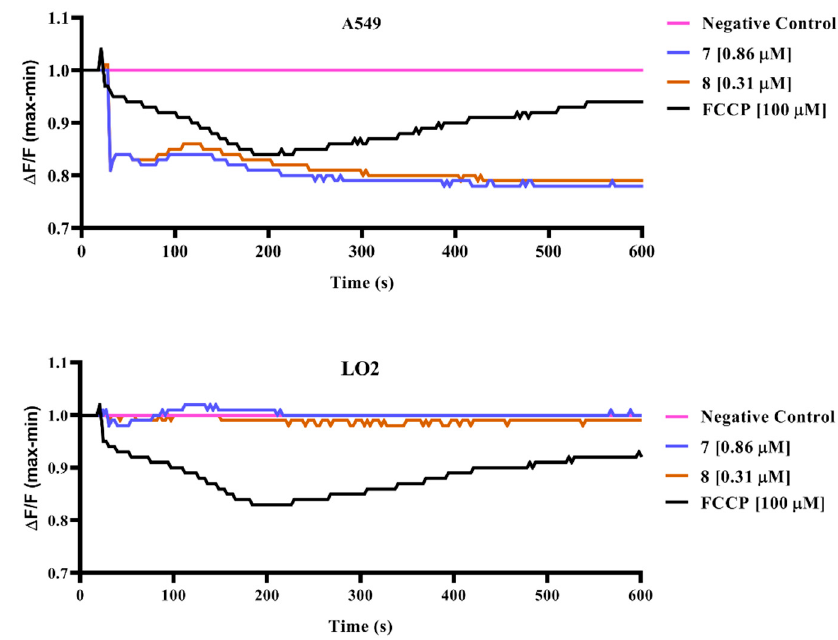
Figure 5. The effects of compound s 7 and 8 on cell membrane potential. The alternation of cell membrane potential was measured in terms of fluorescence. An increase in fluorescence intensity indicates depolarization of cell membrane potential, while a decrease in fluorescence intensity indicates hyperpolarization of cell membrane potential.